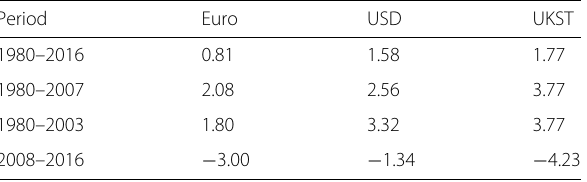
Table 2 Return differentials on 10-year bond portfolios in local currency